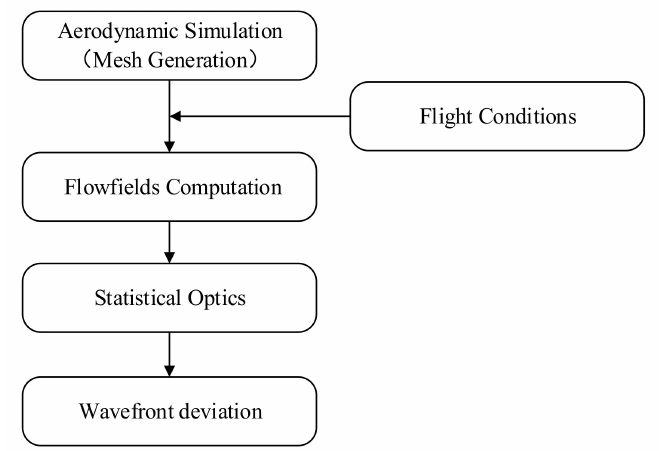
Figure 2. Flowchart of the aero-optical transmission